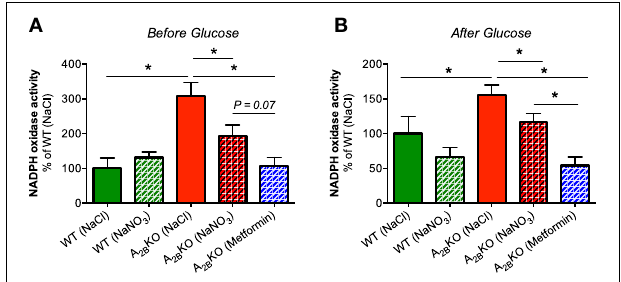
FIGURE 5 | NADPH oxidase activity in the liver. NADPH oxidase-derived superoxide formation was measured with lucigenin-dependent chemiluminescence signal in liver homogenates derived from A 2B KO and WT mice before (A) and after glucose injection (B) . A significantly increased NADPH oxidase activity was observed in A 2B KO compared to WT, which could be diminished by prior injection of nitrate or metformin. Values are mean ± SEM, n = 6 –14/group. * p < 0 . 05 among the indicated groups.